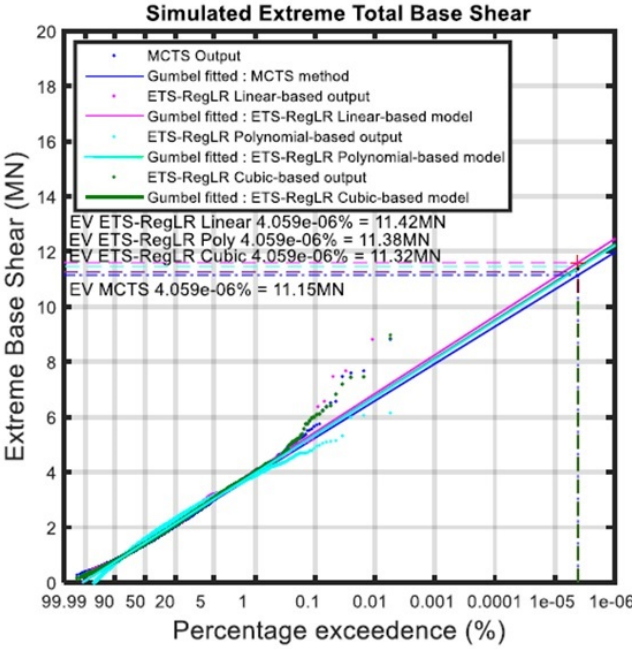
Figure 6. Comparison and validation of ETS-Reg linear, polynomial, and cubic models with the MCTS method. N = 10,000, total quasi-static base shear responses; Hs = 15 m, Tz = 13.75 s, and U = 0.00 m/s.